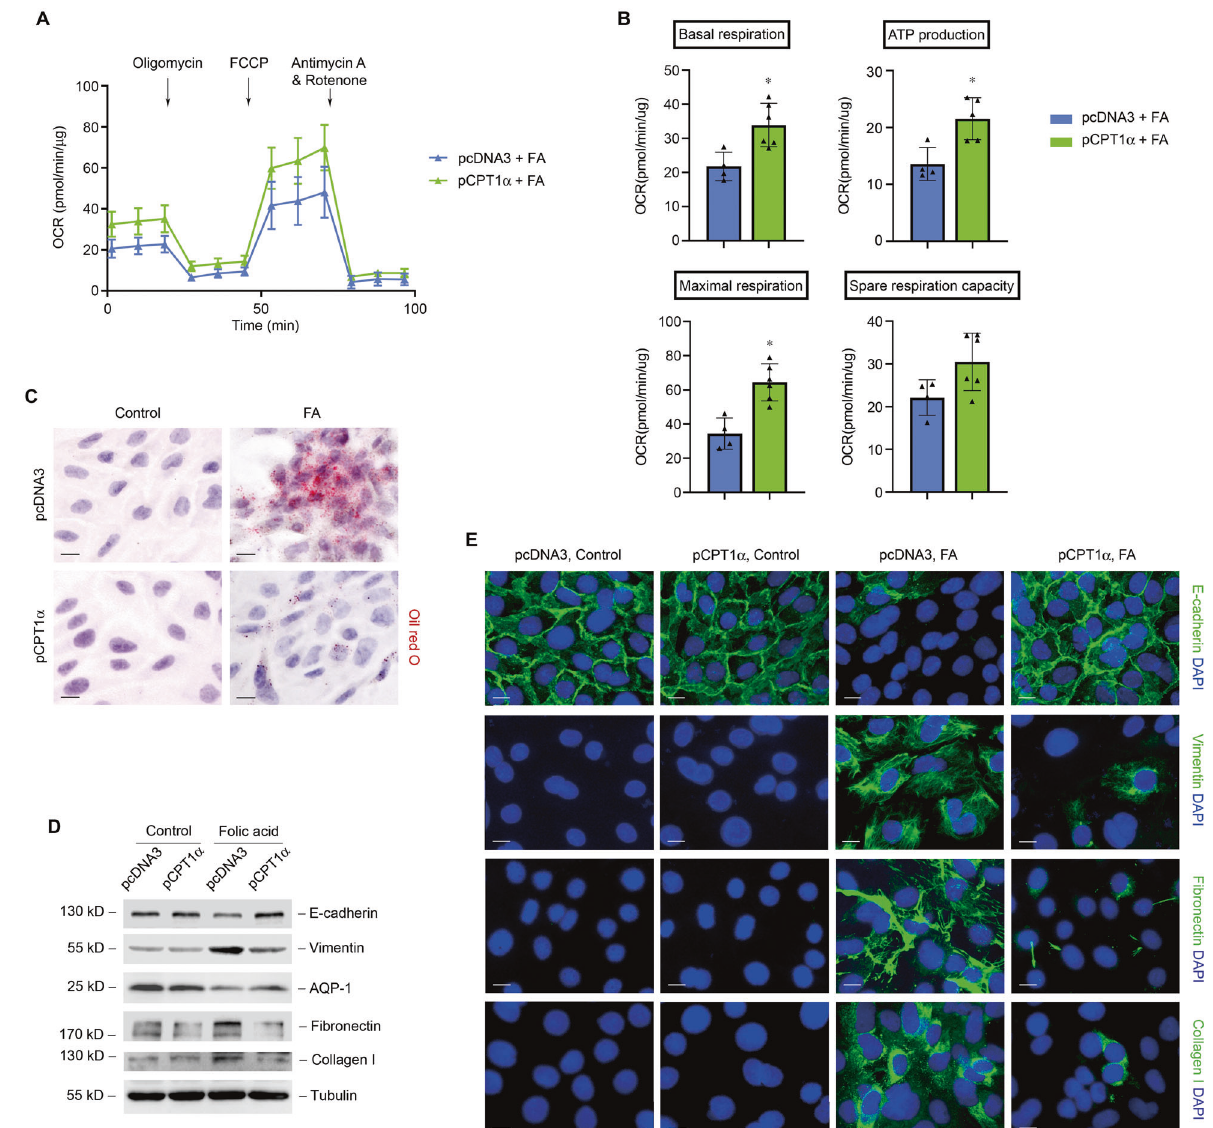
Fig. 8 CPT1 α protects mitochondrial respiration and prevents against folic acid-induced tubular cell damage. A Representative traces show OCR in folic acid-treated tubular cells after transfection with pcDNA3 or CPT1 α plasmid. Oligomycin, FCCP, antimycin A, and rotenone were added. B Summary OCR data from 3 to 4 independent experiments are shown. * P < 0.05 versus pcDNA3 + FA. C Representative images of tubular cells exposed to treatments as indicated stained with oil red O. D Western blot analysis of protein expression of E-cadherin, vimentin, AQP-1, fi bronectin, and collagen I in tubular cells. E Representative images of tubular cells immunostained with E-cadherin, vimentin, fi bronectin, and collagen I. Scale bar, 10 μ